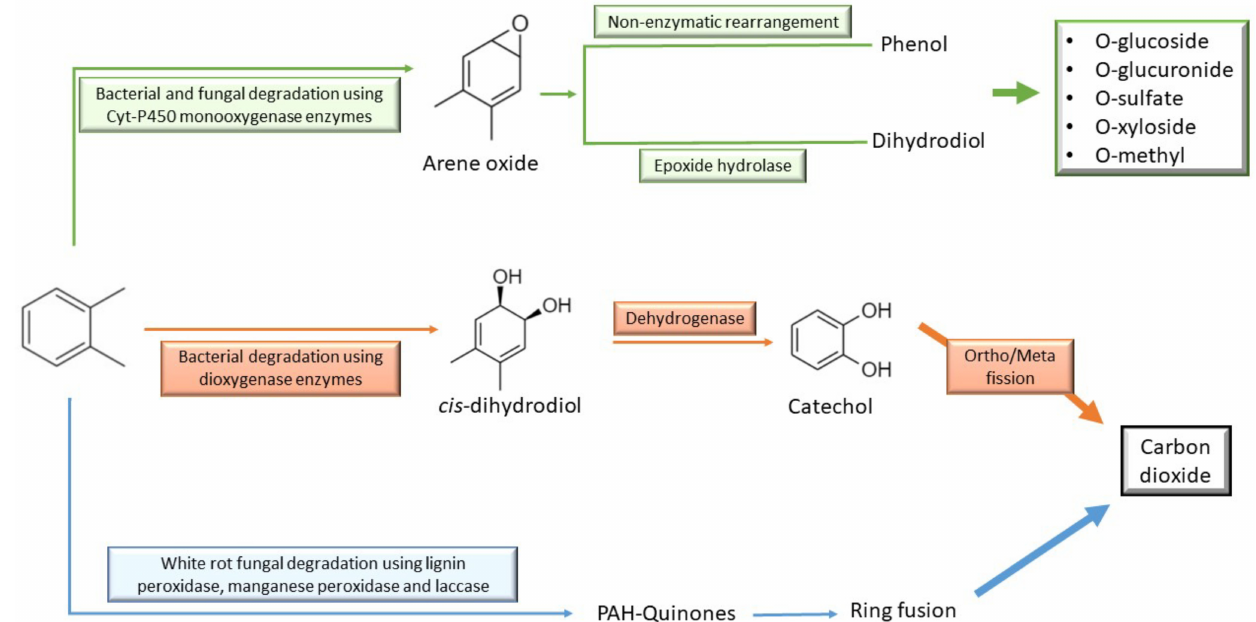
Figure 5. Summarised biodegradation pathway of aromatic hydrocarbons by bacteria and fungi (adapted from